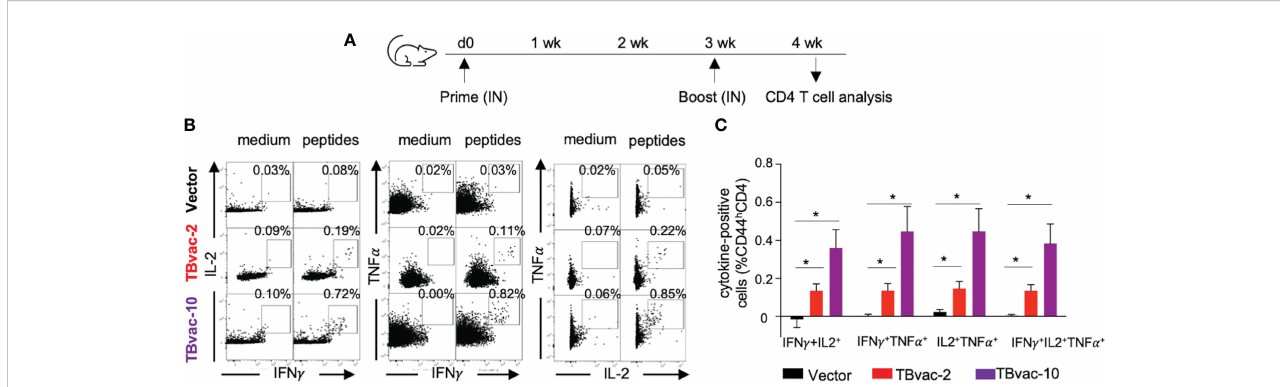
FIGURE 5 rP18tri-based TB vaccines induced multifunctional CD4 T cells. (A) BL6 mice (N=5) were immunized with rP18tri vector (V), TBvac-2, and TBvac-10 through IN-IN prime-boost strategy. At 7 dpb, PBMCs were collected and incubated in medium only or with pooled Ag85B/ESAT6 antigens, and stained for cell surface markers and cytokines. Representative fl ow cytometry plots of CD4 T cells (CD44 h CD4 + CD3 + ) positive for dual cytokine expression (IFN g /IL-2, IFN g /TNF a , and IL-2/TNF a ) after either medium or peptide stimulation were shown for each immunization group (B) . After normalization with the medium control, the average percentages of dual- and triple-positive (IFN g /IL-2/TNF a ) CD4 T cells after peptide stimulation were shown for each group (C) .